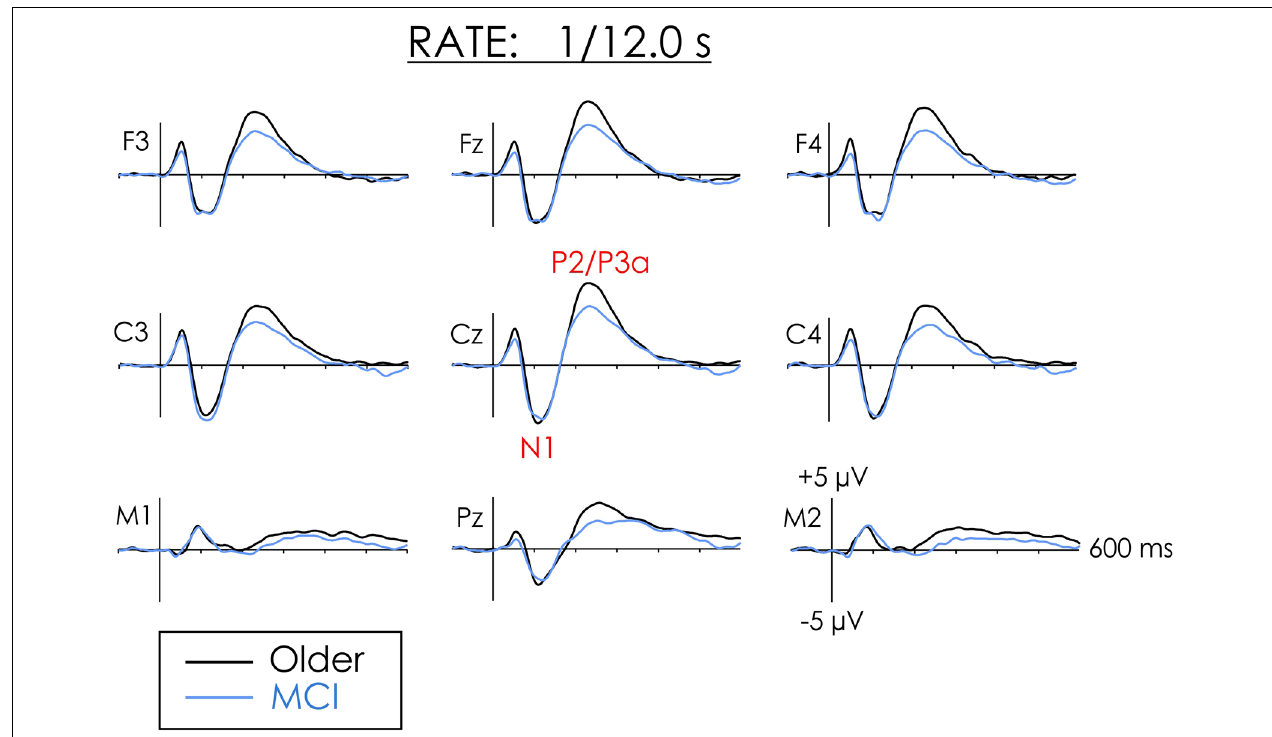
FIGURE 2 | Grand averaged ERPs from healthy older adults and people with MCI in the slow rate of presentation condition. The amplitude of N1 did not differ between the groups. The amplitude of P2 was larger for healthy older adults than people with MCI at both the frontal and central regions of interest